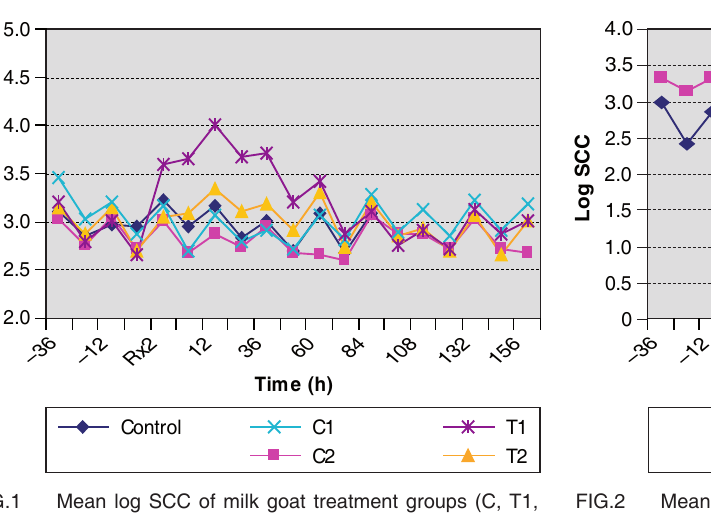
FIG.1 Mean log SCC of milk goat treatment groups (C, T1, C1, T2, C2) over time (h)